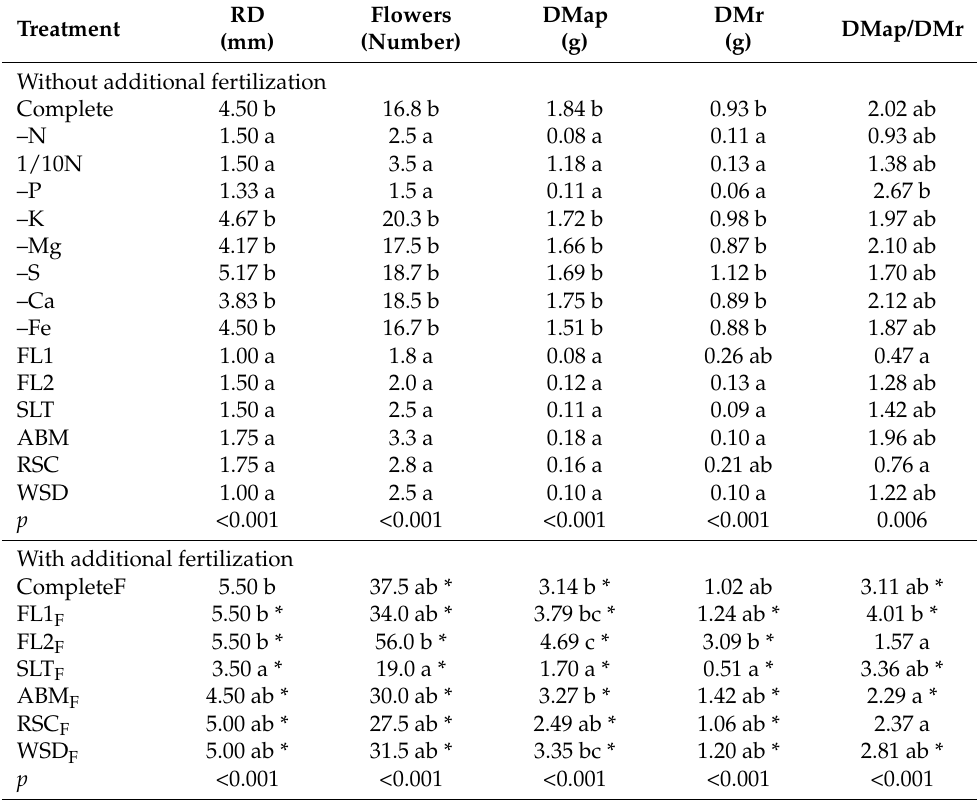
Table 11. Mean values at the end of the mineral nutrition and substrate trials, both without and with additional